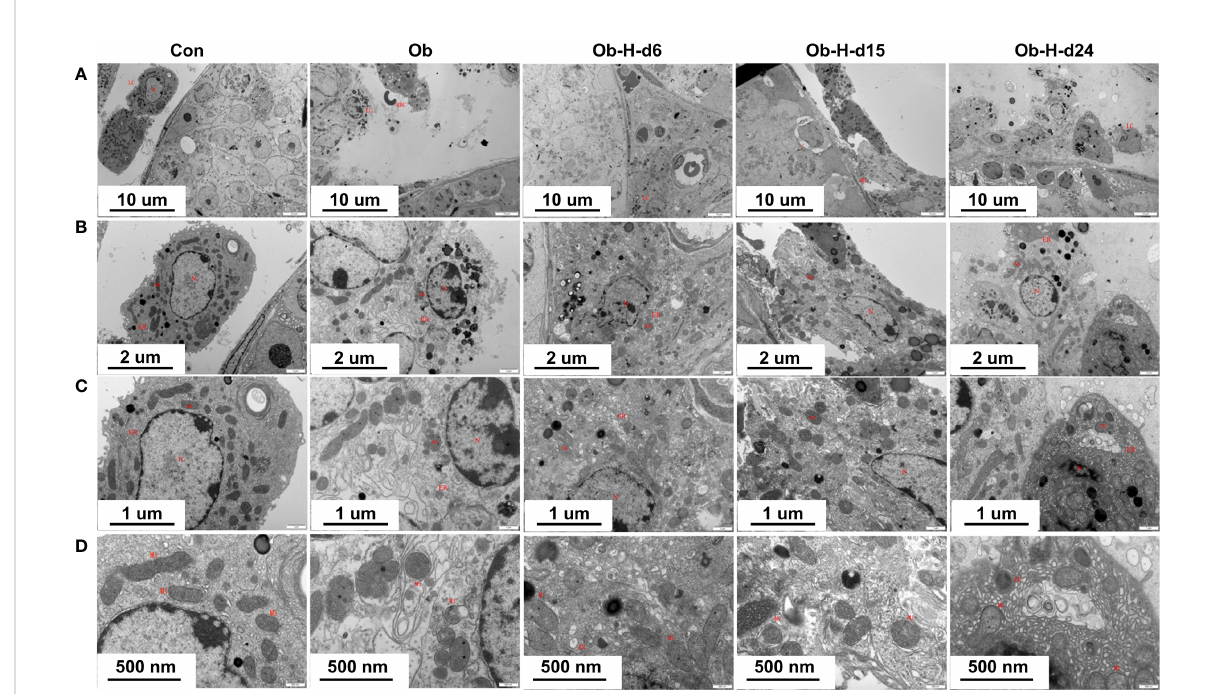
FIGURE 7 Impacts of chronic high-altitude hypoxia on the mitochondria of LCs in obese male mice. Representative TEM images showing the morphology of mitochondria, nucleus, and membrane from each group. Magni fi cation: (A) 3,000×, scale bar = 10 m m; (B) 8,000×, scale bar = 2 m m; (C) 15,000×, scale bar = 1 m m; (D) 30,000×, scale bar = 500 nm. (A, B ,C ,D): n = 3; Mitochondrial (Mi); Nucleus (N); Endoplasmic reticulum (ER); Red blood cell (RBC); Leydig cells (LCs). Con, Control group; Ob, Obese group; Ob-H, Obese-Hypoxia